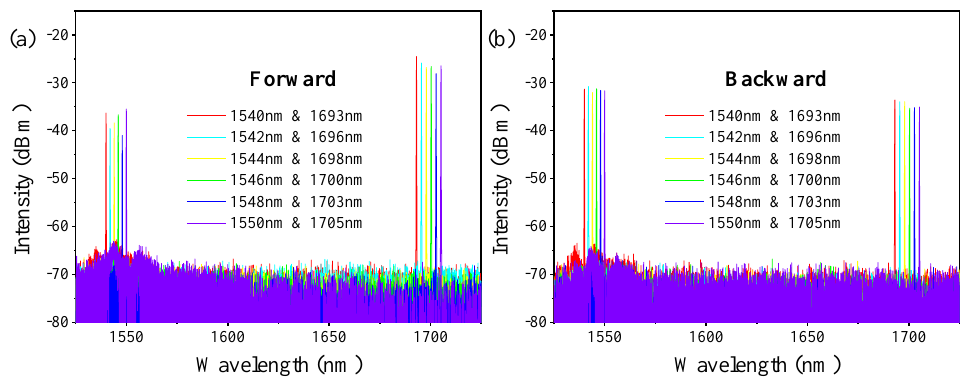
Figure 2. The output spectrum of ( a ) the forward and ( b ) the backward laser at the maximum pump power.